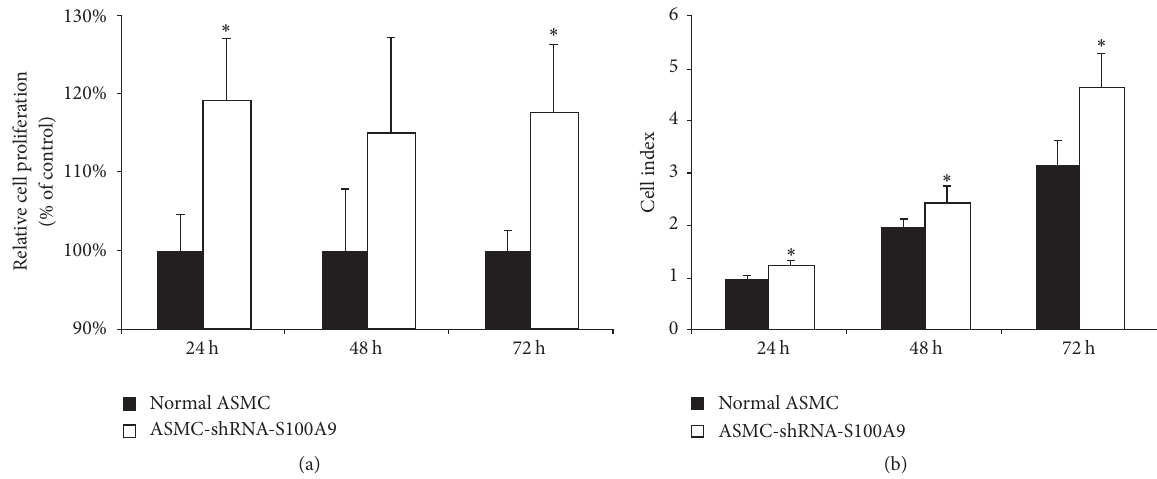
Figure2:EffectofstableknockdownofS100A9expressiononairwaysmoothmusclecellularproliferation.(a)PDGF-inducedproliferationin ASMC-shRNA-S100A9 cells measured by the WST-1 assay at 24 h, 48 h, and 72 h. (b) PDGF-induced proliferation in ASMC-shRNA-S100A9 cells measured by the real-time cellular assay at 24 h, 48h, and 72 h. ∗ indicates a significant difference as compared to control ASMCs ( 𝑃 < 0.05 ). All data are presented as the means ± SD, 𝑛 = 4